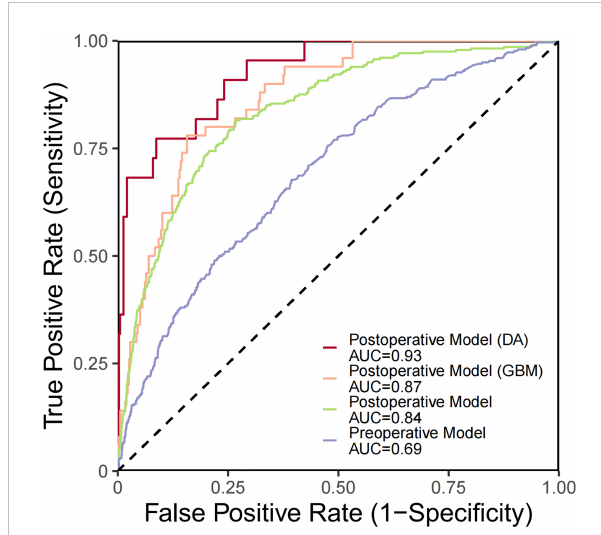
FIGURE 3 ROC curves generated for PMHD prediction with different clinical periods and subgroups. DA, diffuse astrocytoma, IDH-mutant; GBM, glioblastoma,